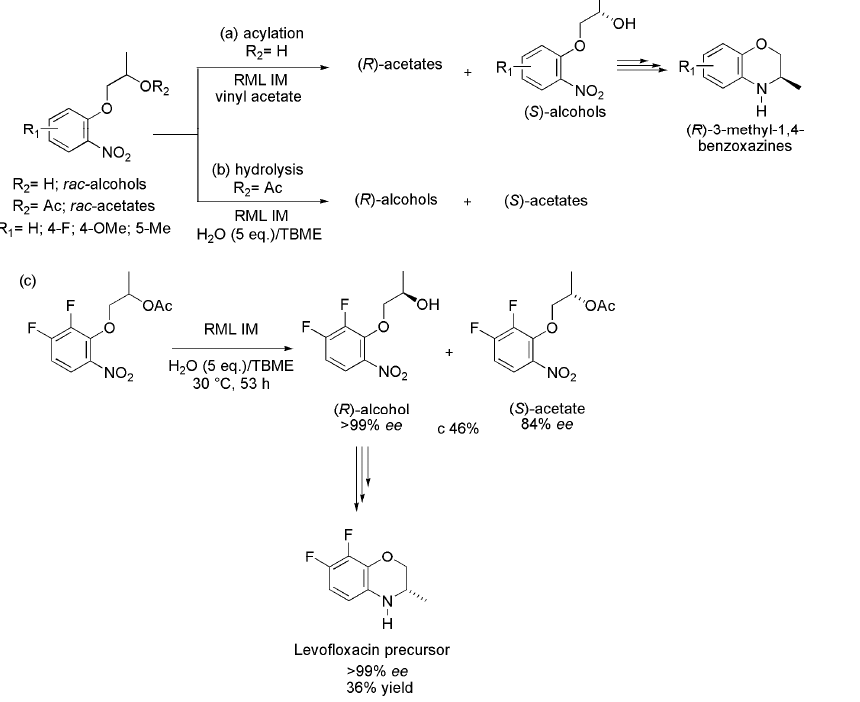
Scheme 46. Enzymatic kinetic resolution of racemic alcohols 1-(2-nitrophenoxy)propan-2-ols via acetylation ( a ) or via hydrolysis ( b ) of the corresponding racemic acetates. Production of ( S )-7,8- difluoro-3-methyl-3,4-dihydro-2 H -benzo[ b ][1,4]oxazine precursor of the antibacterial drug Levofloxacin ( c ) [70]. Results from the enzymatic kinetic resolution of racemic alcohols 1-(2-nitrophenoxy) propan-2-ols via acetylation (a) or via hydrolysis (b) of the corresponding racemic acetates [70].